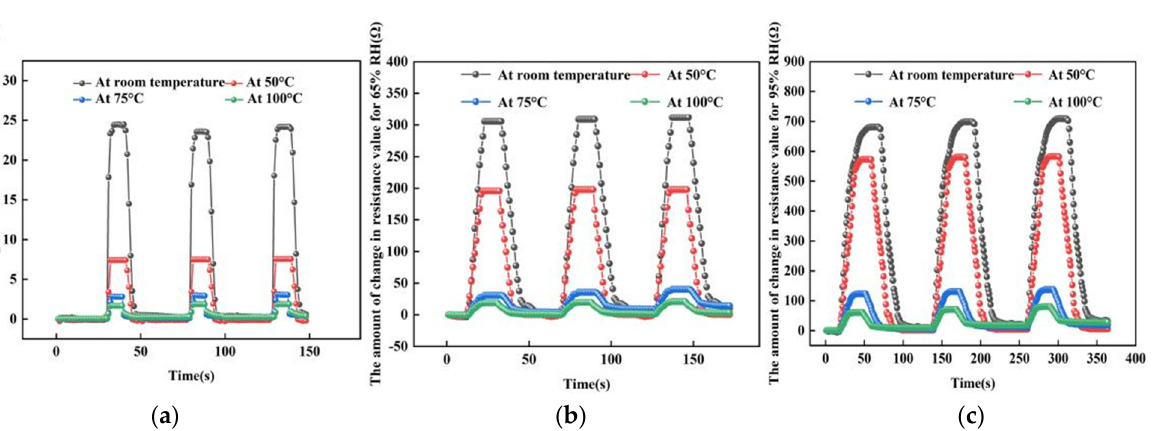
Figure 13. The response-recovery line tests at different humidity environments. ( a ) At 35% RH. ( b ) At 65% RH. ( c ) At 95% RH.